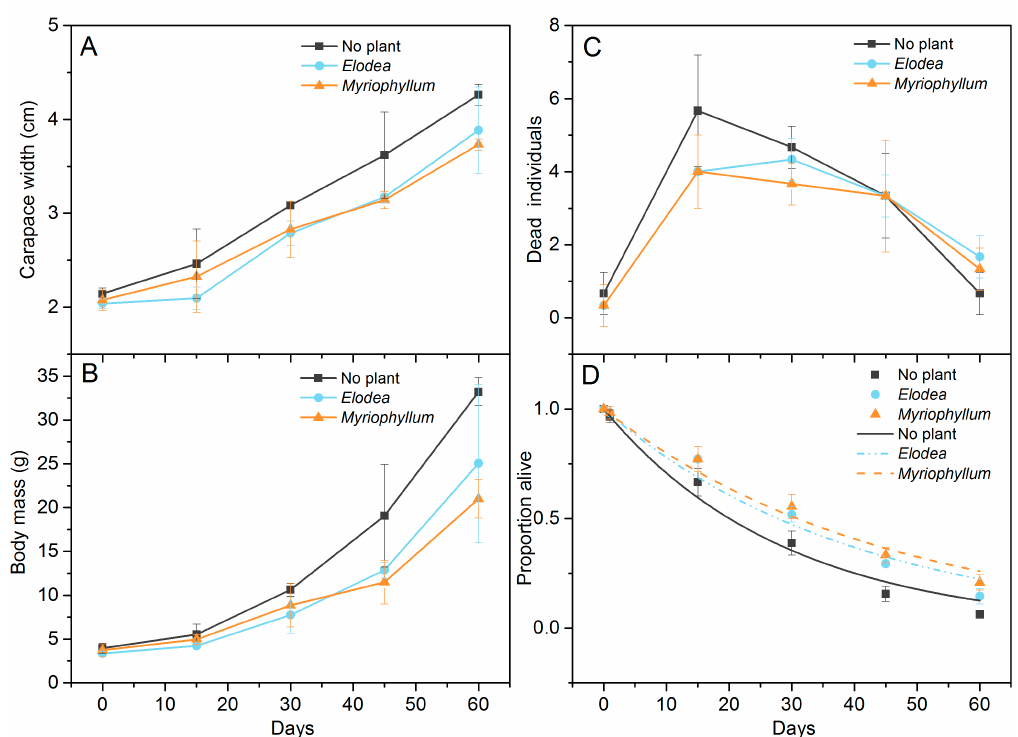
Figure 4. Temporal trends of carapace width (cm) ( A ) and wet body mass (g) ( B ) of the experimental crabs and crab mortality (individual) ( C ) and alive proportion ( D ) in the cannibalism experiment. Error bars represent standard deviation ( n = 3). The lines illustrate the preferred exponential loss model ( p = e − mt ) ( D ).